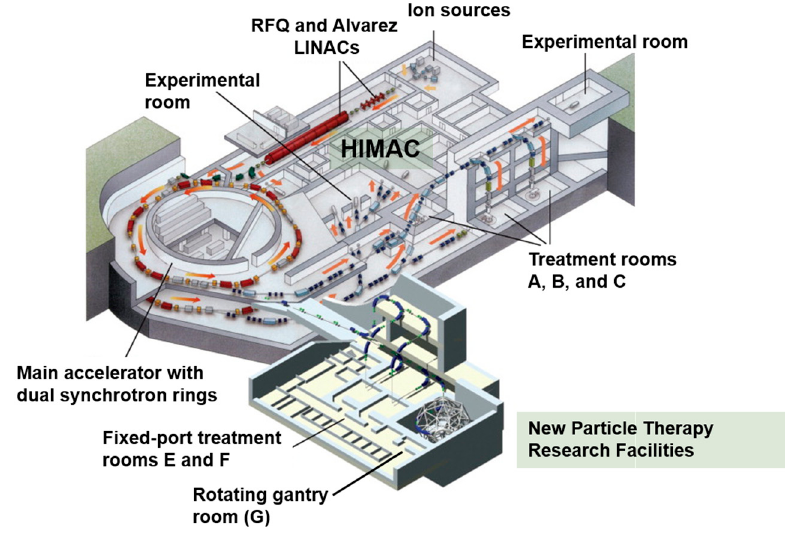
Figure 3. Overview of the HIMAC and New Particle Therapy Research Facilities at the National Institute of Radiological Sciences in Chiba, Japan.